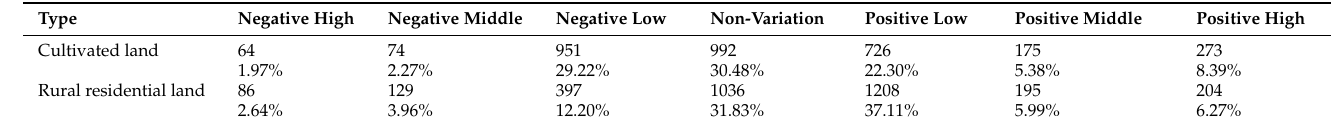
Figure 5. The proportion of matching modes distribution between 2009 and 2018 (( A ): cultivated land, ( B ): rural residential land).